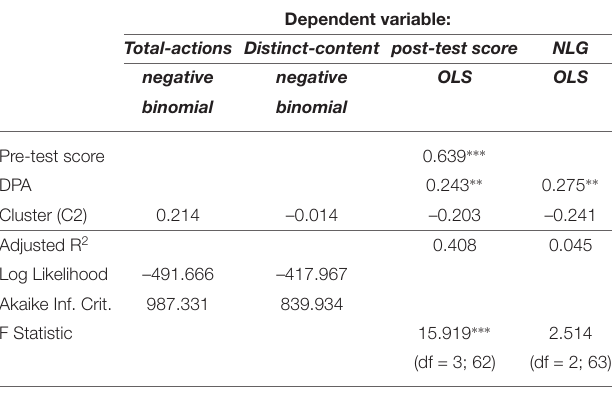
TABLE 6 | Summary of the fitted regression models to predict engagement and performance measures by categorical cluster labels. Dependent